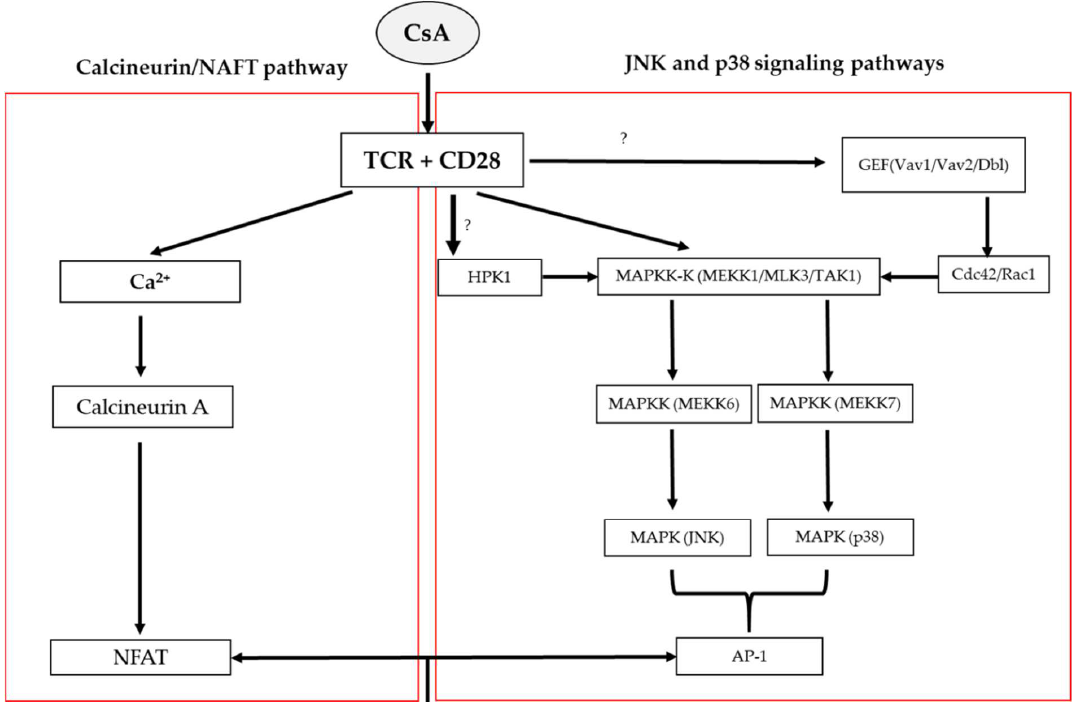
Figure 2. The mechanism of CsA action on the calcineurin/NAFT pathway and JNK and p38 signaling pathways in T cells. CsA, cyclosporine-A; T cell receptor, TCR; Guanine nucleotide exchange factor, GEF; Vav Guanine Nucleotide Exchange Factor 1, 2, Vav1, Vav2; diffuse B-cell lymphoma, Dbl; Hematopoietic progenitor kinase, HPK1; Mitogen-Activated Protein kinase kinase kinase, MAPKK-K also known as MEKK1/MLK3/TAK1; Mitogen-Activated Protein kinase kinase, MAPKK also known as MEKK6/MEKK7; The c-Jun N-terminal kinase pathway, JNK; Activator protein 1, AP-1; Cell Division Cycle 42, Cdc42; Ras-related C3 botulinum toxin substrate 1, Rac1; Nuclear factor of activated T-cells, NFAT.